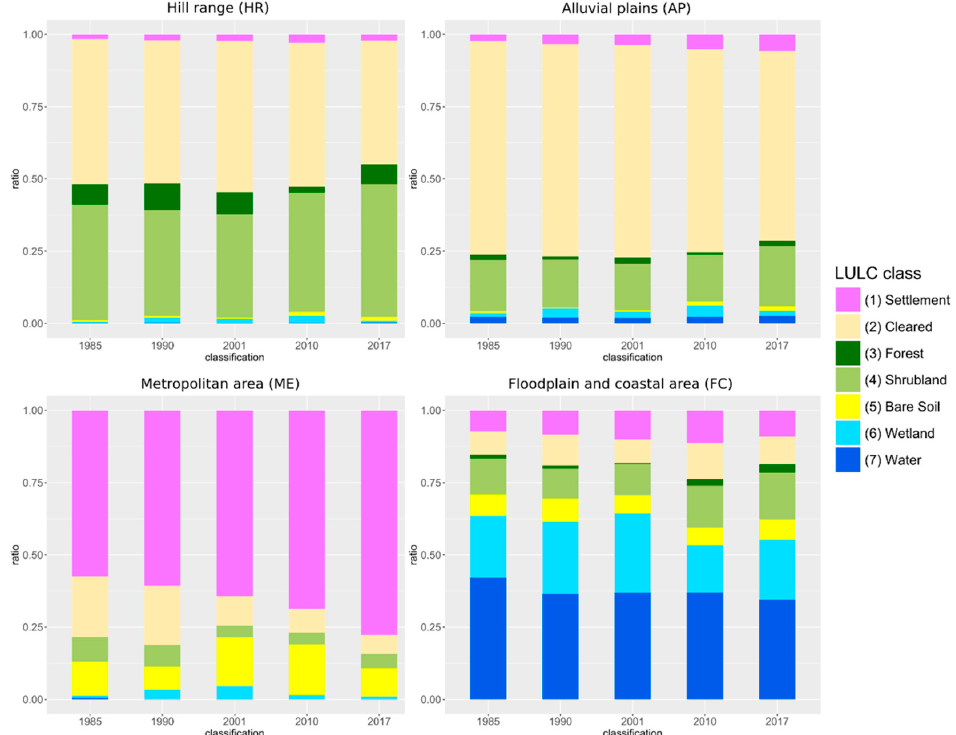
Table 5. Changes of area size per land use and land cover class in the hinterland of Barranquilla for